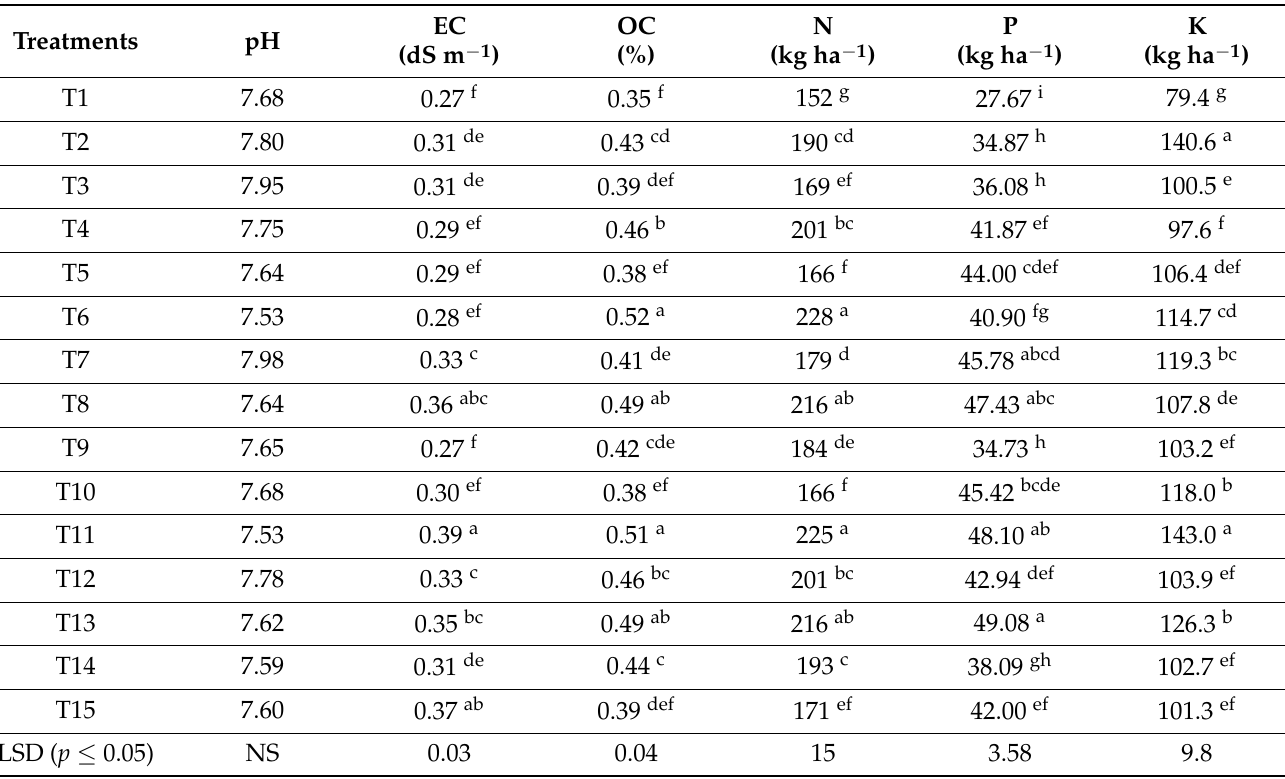
Table 6. Interactive effect of manures and fertilizers on soil properties after the harvesting of wheat crop,